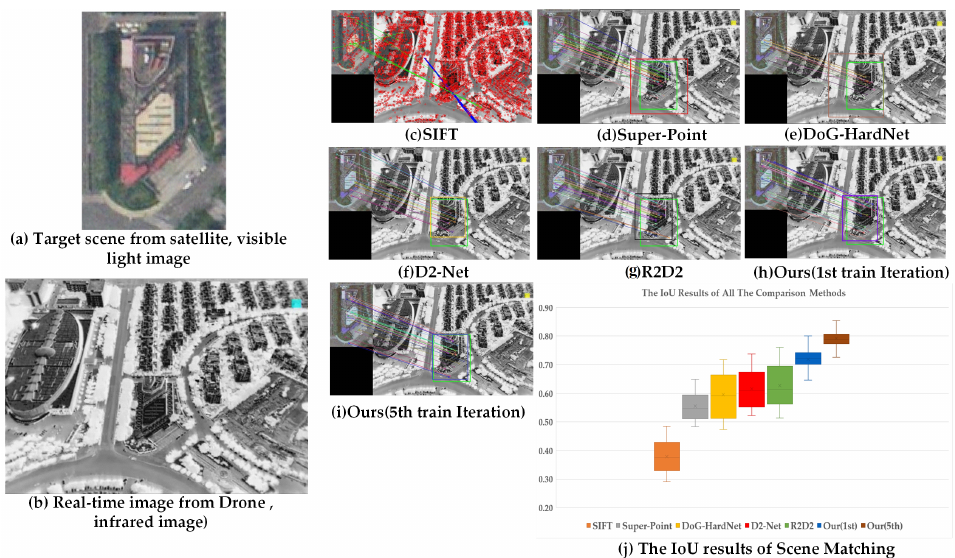
Figure 11. RGB-IR image pairs sample from our test dataset and the image matching results of all the comparison methods. ( a ) is a reference visible light image from Google Earth. ( b ) is the real-time infrared image captured at different view-point. ( c ) is the matching result of sample image from SIFT. ( d ) is the matching result of sample image from Super-Point. ( e ) is the matching result of sample image from DoG-HardNet. ( f ) is the matching result of sample image from D2-Net. ( g ) is the matching result of sample image from R2D2. ( h ) is the matching result of sample image from the first train iteration of our method. ( i ) is the matching result of sample image from the fifth train iteration of our method. ( j ) is the IoU results of all the image matching tests.